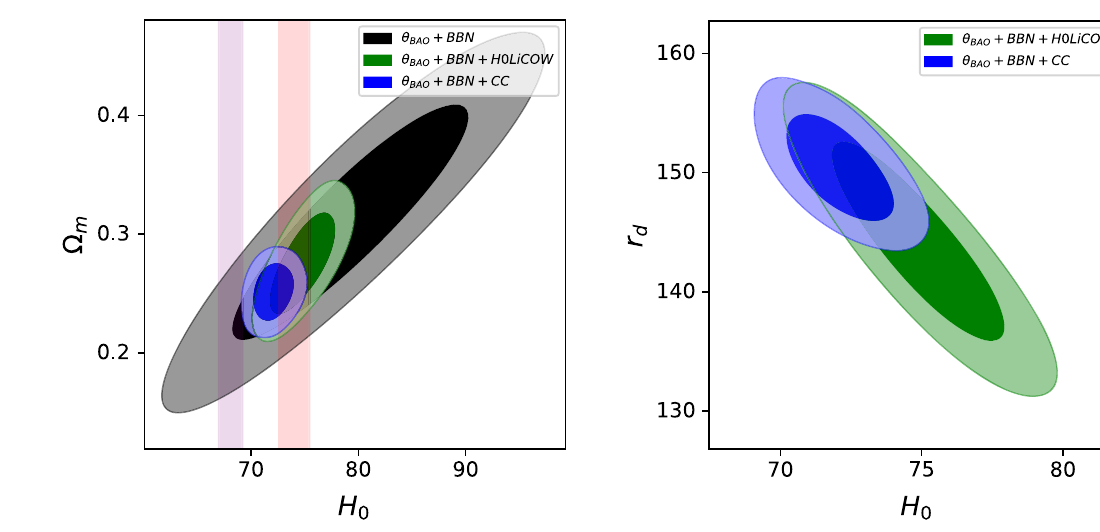
measurement [2], respectively. Right panel: The 68% CL and 95% CL regions in the H 0 − r d plane from θ BAO + BBN + H0LiCOW and θ BAO + BBN + CC analyses. The parameter H 0 is measured in units of km s − 1 Mpc − 1 and r d in